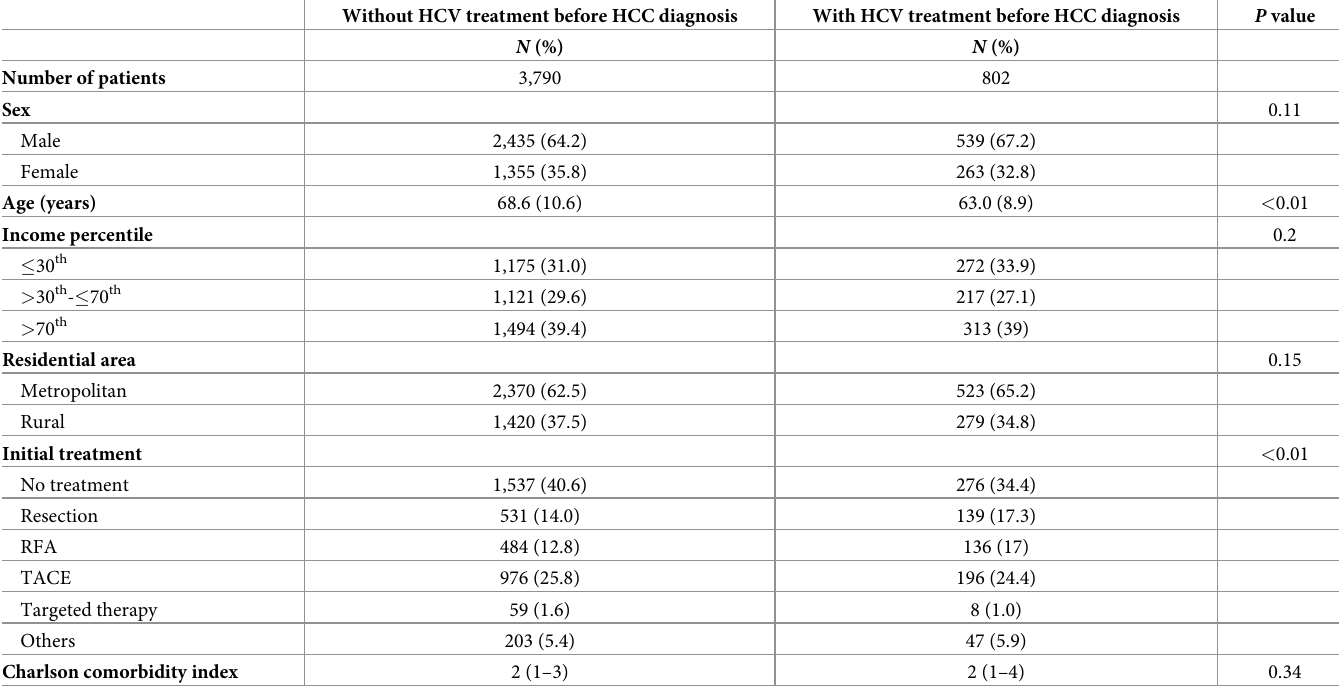
Table 1. Characteristics of study participants with and without prior hepatitis C virus treatment who were diagnosed with hepatocellular carcinoma. Without HCV treatment before HCC diagnosis With HCV treatment before HCC diagnosis P